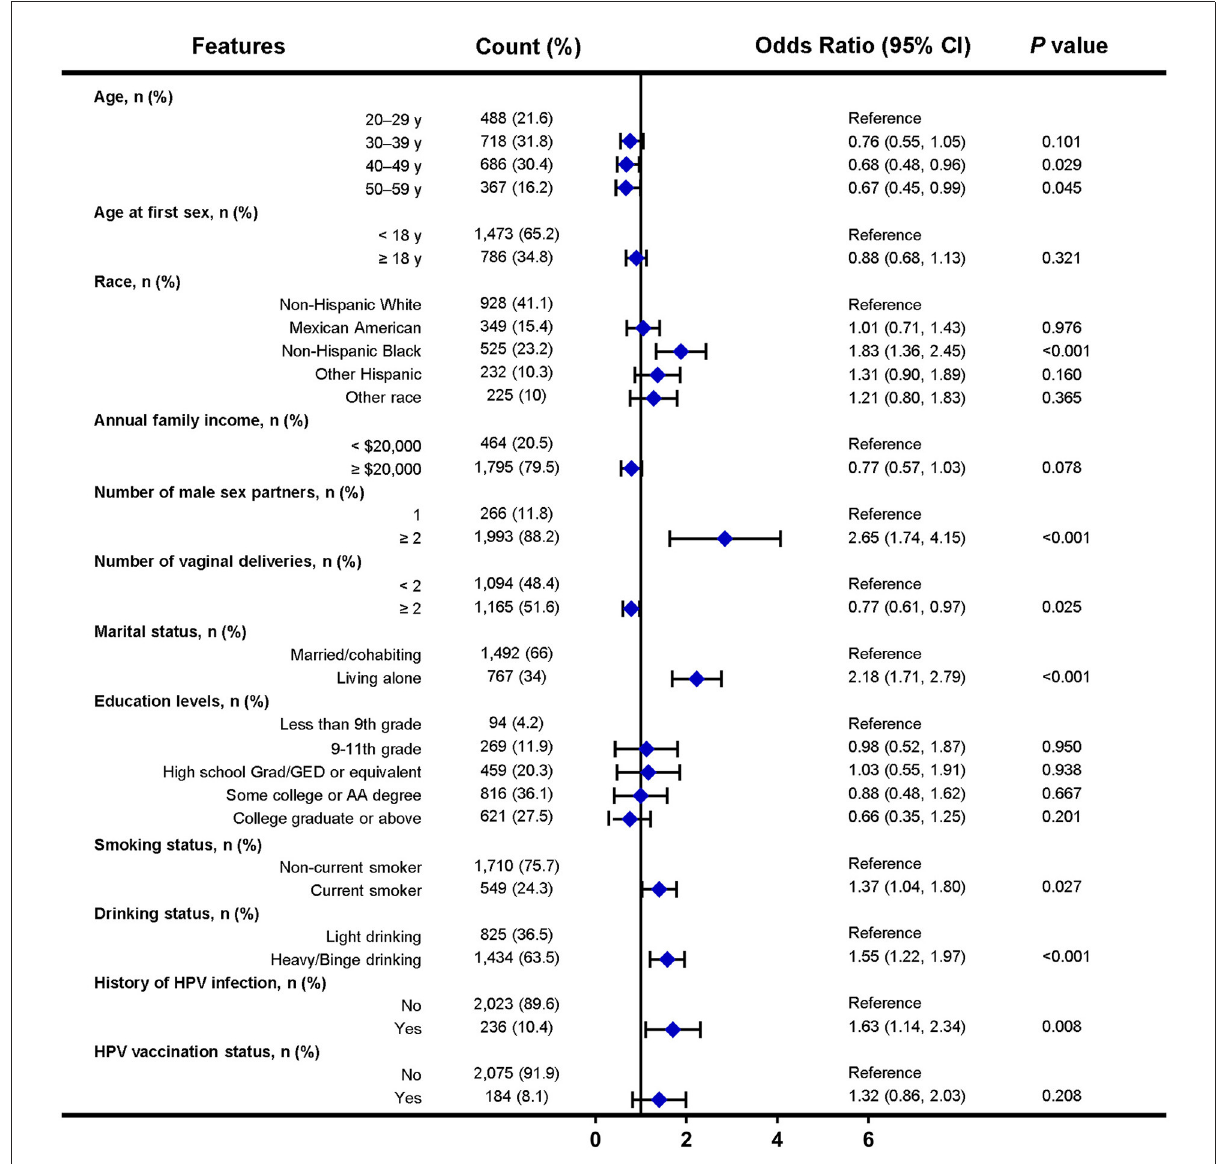
FIGURE3 Forest plot of multivariable logistic regression analysis in the training set of NHANES cohort. The x-axis represents the odds ratio scale. An odds ratio > 1 indicates increased odds of HPV infection, whereas an odds ratio < 1 suggests decreased odds of HPV infection. CI, confidence interval.